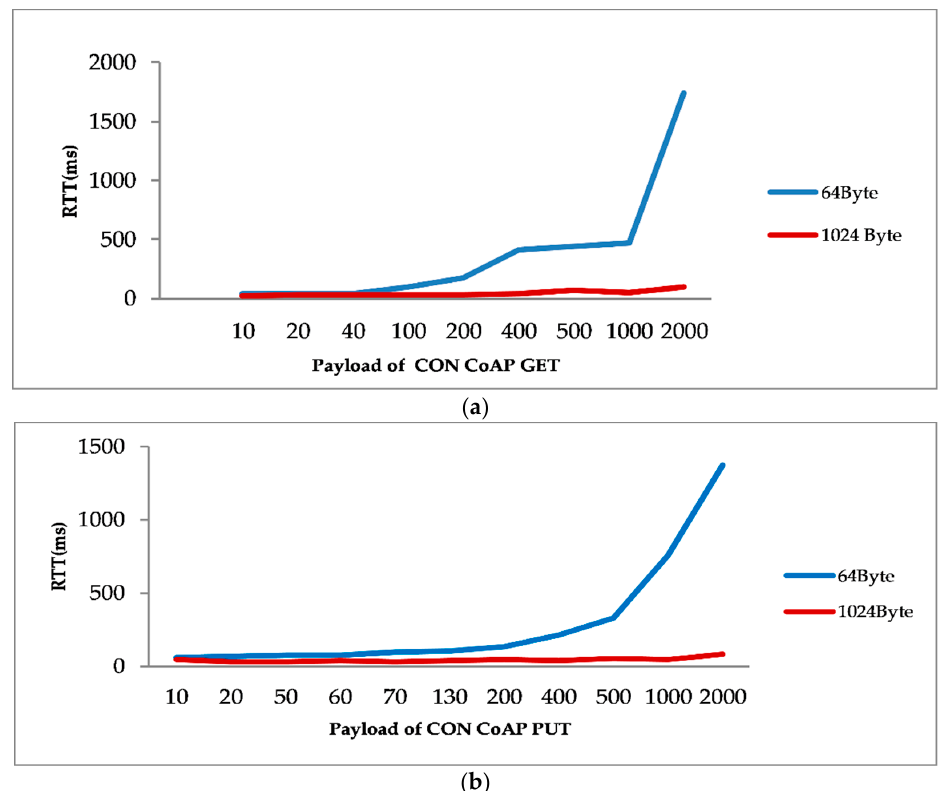
Figure 9. Impact of different CoAP data block size on performance: ( a ) CoAP GET RTT; and ( b ) CoAP PUT RTT.